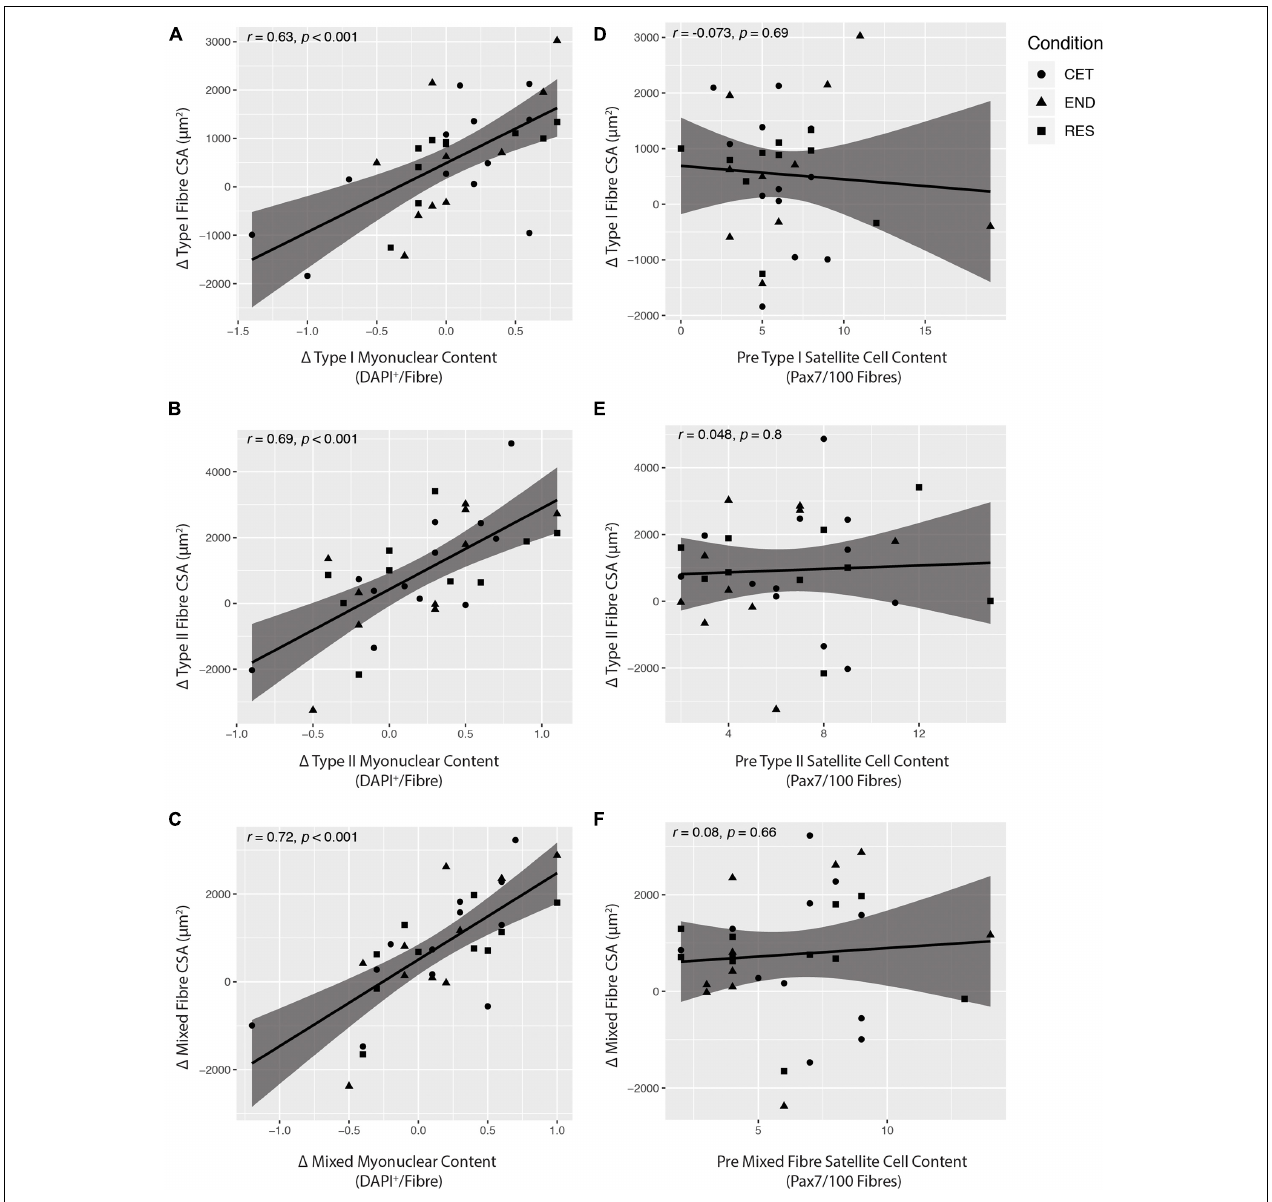
FIGURE 6 | Pearson correlation coefficients (r) showing the relationship between fibre type-specific changes in cross-sectional area (CSA) and myonuclear content (A–C) and fibre type-specific changes in CSA and pre-intervention baseline satellite cell content (D–F) . Statistical significance was set at P < 0.05. CET, concurrent training; END, endurance training; RES, resistance